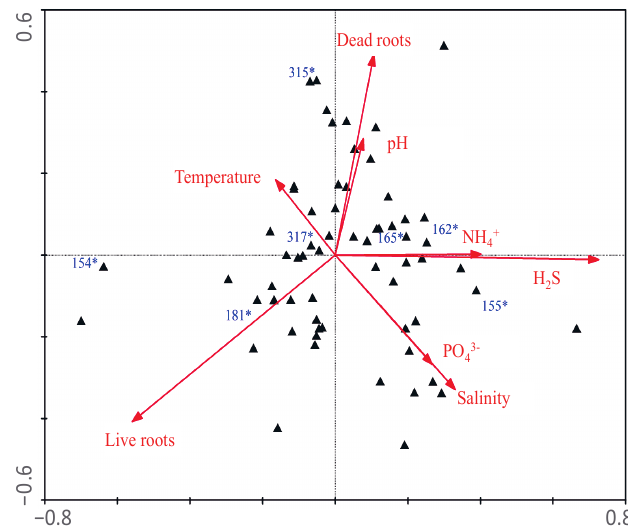
Figure 2. Ordination plot of pRDA results for nifH OTUs in the studied area (72% explained variance, p < 0.05). Triangles indicate OTUs at their best position in the plot relative to the environmental parameters (shown as arrows). The positions of seven TRFLP-OTUs (clone phylotypes that matched the TRFLP-OTUs) are shown in blue by their OTU #. The length of the arrows indicates the strength of environmental parameters in explaining OTU abundance variability. Arrows with same direction represent positive correlated variables, whereas arrows at a 90° angle represent uncorrelated